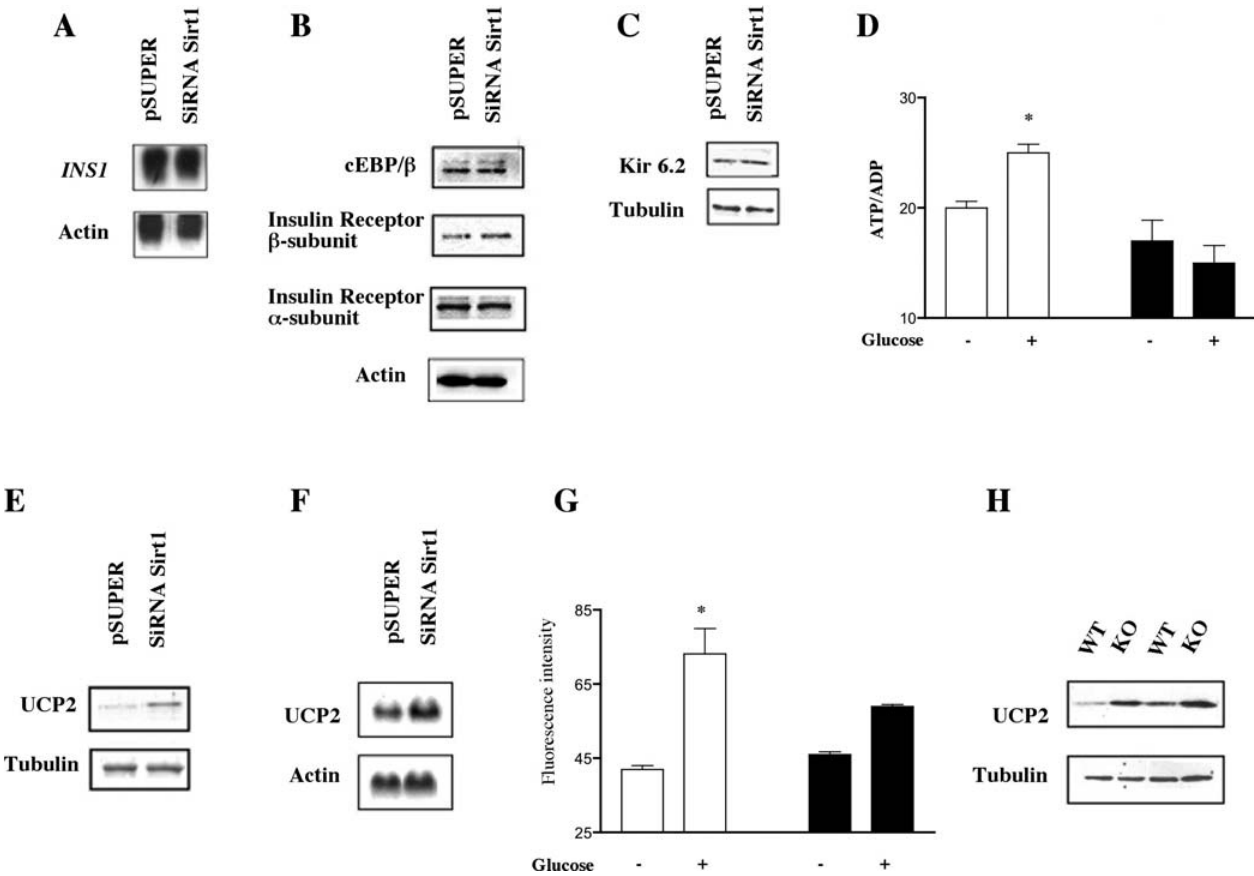
Figure 4. UCP2 is Up-Regulated in Sirt1 Knockdown Cells and in Sirt1 KO Mice (A) Northern blot for the insulin gene INS-1 in cells with a control vector (pSUPER) or a SiRNA-Sirt1 vector (SiRNA Sirt1). (B and C) Western blot analyses of targets involved in insulin synthesis and secretion using specific antibodies: cEBP/ b , insulin receptor a and b , and kir6.2, one of the K þ channel receptor subunits. (D) Measurement of ATP/ADP levels in INS-1 control cells (open bars) or Sirt1 knockdown cells (black bars) treated with 16.7 mM glucose ( þ ) or 4 mM glucose ( (cid:1) ) ( n ¼ 3 experiments done in triplicate, * p , 0.005 in the pSUPER experiment; ANOVA). (E) Western blot analysis for UCP2 in INS-1 control cells (pSUPER) or knockdown cells (SiRNA Sirt1). (F) Northern blot analysis for UCP2 in INS-1 control cells (pSUPER) or knockdown cells (SiRNA Sirt1). (G) NADH levels in INS-1 cells after glucose addition as determined by autofluorescence [46] and expressed as arbitrary units. Cells stably transfected with control or Sirt1 SiRNA vectors were used ( n ¼ 2, * p , 0.05 compared with no glucose). (H) UCP2 protein levels in isolated pancreatic islets of two wild-type or two Sirt1 KO mice. Tubulin or actin was used as loading control in all Western and Northern blots. DOI: